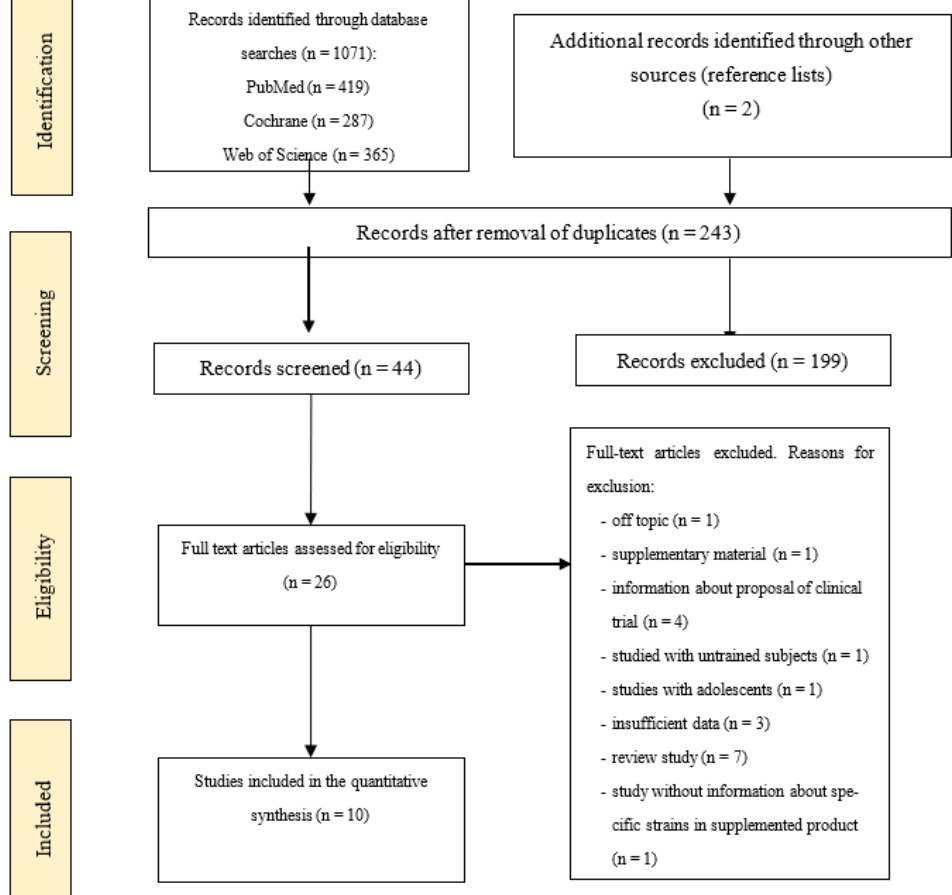
Figure 1. Flow diagram showing the study selection process.